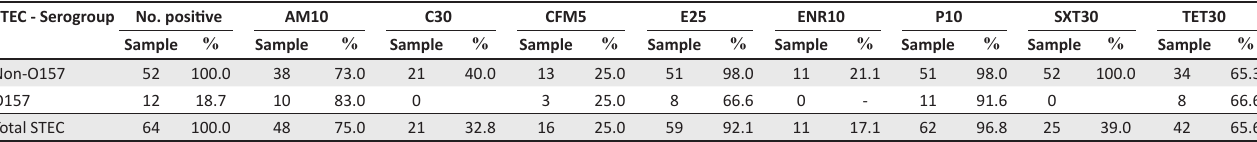
TABLE 3: Antibiotic resistance pattern in Shiga toxin–producing Escherichia coli strains. STEC - Serogroup No. positive